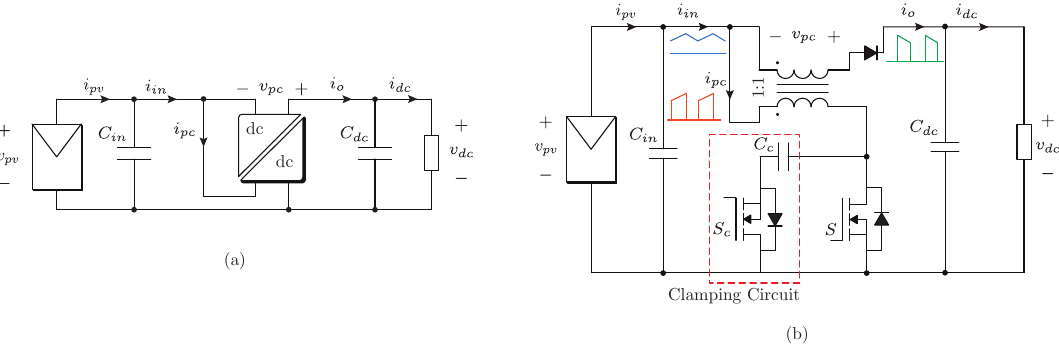
Figure 2. ( a ) Configuration of the partial power converter. ( b ) Proposed topology using a Flyback